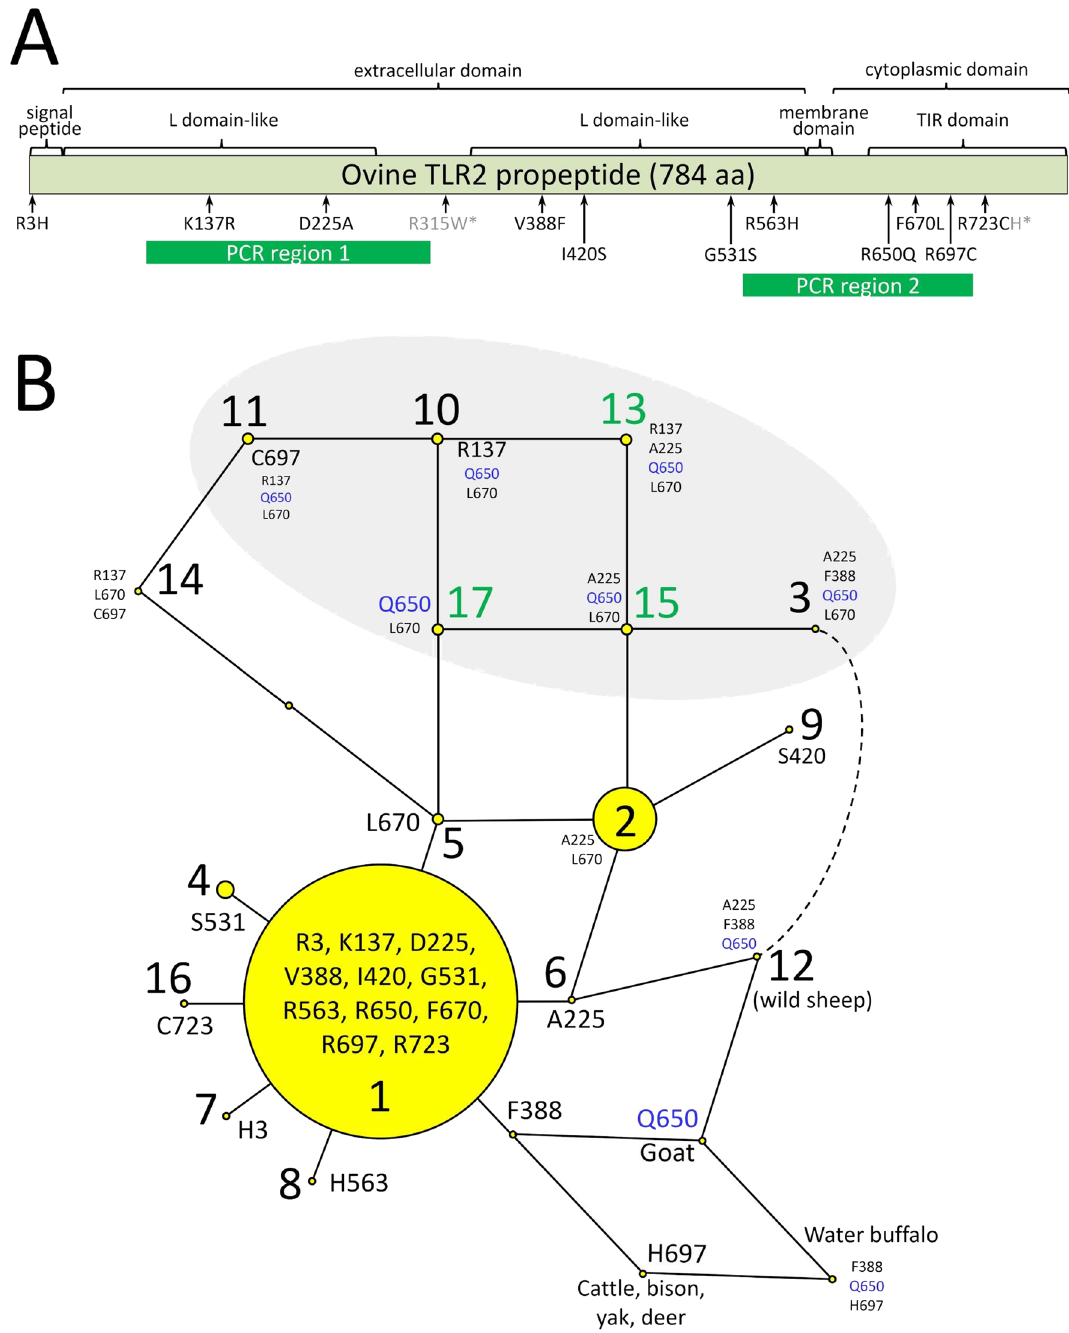
Figure 1. Physical map and phylogenetic tree of phased peptide variants encoded by TLR2 . ( A ) Sites of amino acid substitution with respect to protein domains. ( B ) Rooted maximum parsimony tree showing relationships of predicted polypeptide isoforms from 171 sheep from 56 breeds. The most frequent TLR2 isoform (“variant 1”) was used as the reference sequence. For “variants 1” through “17”, each node in the tree represents an TLR2 propeptide isoform with one amino acid different compared to adjacent nodes. The areas of the circles are proportional to the variant frequency in the combined group of MSDPv2.4 and ISGC75 sheep panels (n = 171). The grey shaded area encompassed Q650 isoforms in domestic sheep. Loop structures indicate recombination of haplotypes within populations. The TLR2 haplotype nodes in non- Ovis aries species were based only on the 11 amino acids positions variant in sheep. The dashed line indicates two species nodes that differ by one variant